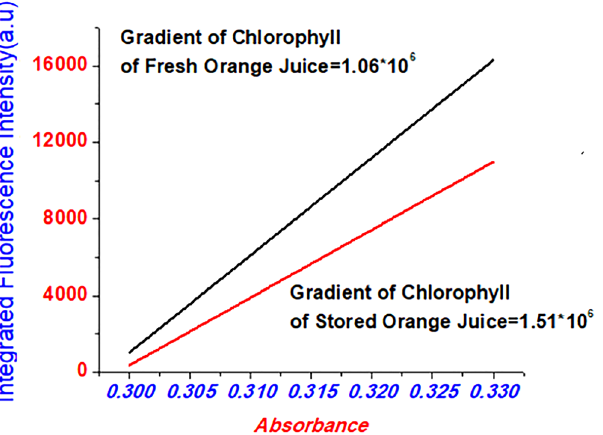
Figure 7. The proportionality of samples found in chlorophyll Fluorescence quantum esteem on Orange